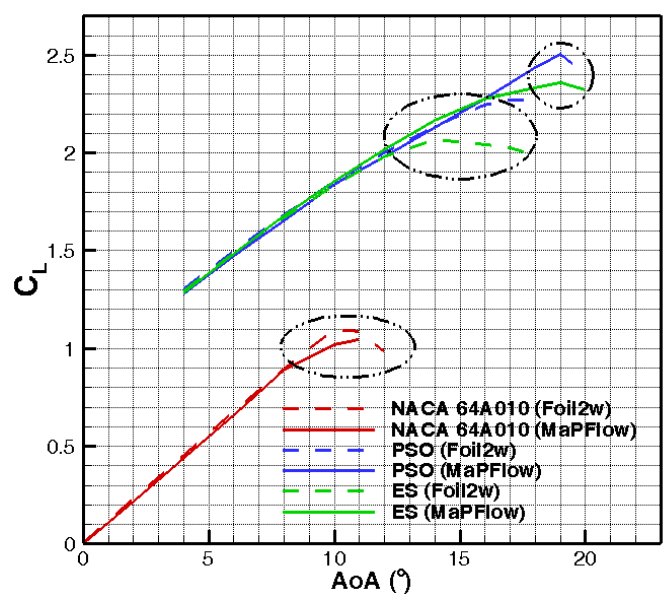
Figure 14. C L polars produced by Foil2w (dotted lines) and MaPFlow (continuous lines) for the PSO and ES geometries, along with the C L polars of the original airfoil. The marked regions denote the appearance of C L,max and the operation points of interest. Table 6. Relative increase in CL,max for the PSO and ES airfoils, using Foil2w and